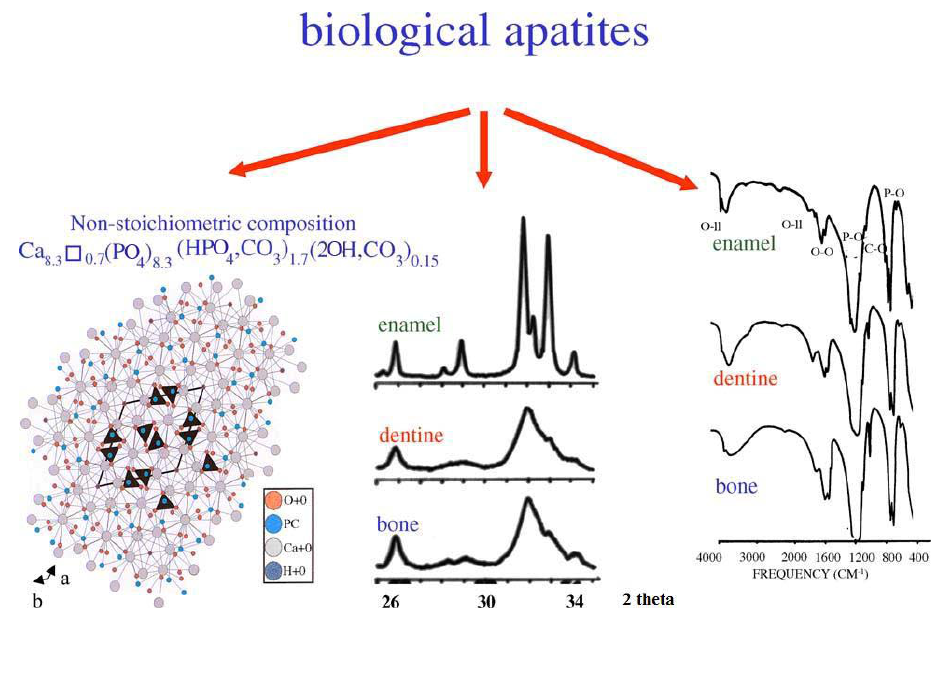
Figure 5. Crystal structure of biological apatites. Powder X-ray diffraction patterns and infrared spectra of enamel, dentine and bone. Reprinted from Ref. [355] with